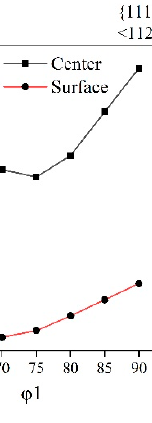
Figure 17. Texture intensity along the γ fiber of the surface and center layer of samples rolled with lubrication.